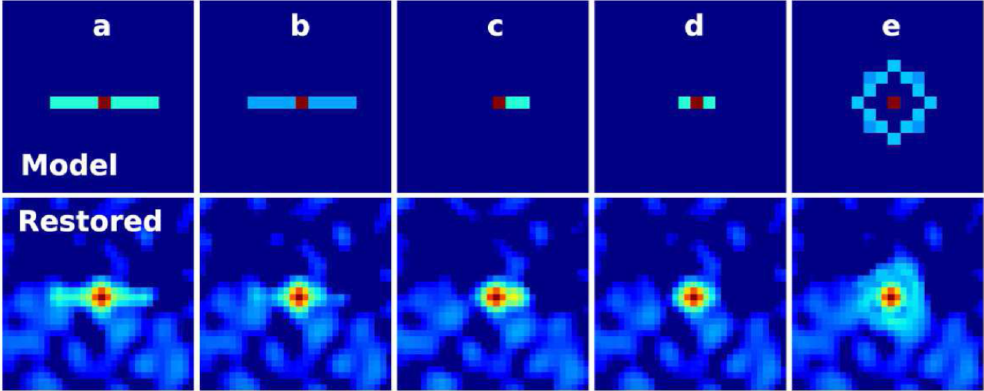
Figure 4. Input models and restored maps using NIRISS aperture masking interferometry (AMI) observations that combine two observations oriented perpendicularly (such orientations would be spaced apart by ∼ 3 months) for a variety of sky geometries (adapted from [46]). The simulation suggests that a 100:1 pixel-to-pixel contrast is easily reachable with image reconstruction. ( a ) The integrated flux from the bar is 1 mag fainter than the point source. ( b ) The bar is 2 mags fainter than the point source. ( c ) An asymmetric 3-pixel bar with the same surface brightness as the bar in ( a ), and ( d ) a similar symmetric bar. ( e ) A 5-pixel diameter circular ring with integrated flux 1 mag fainter than the point